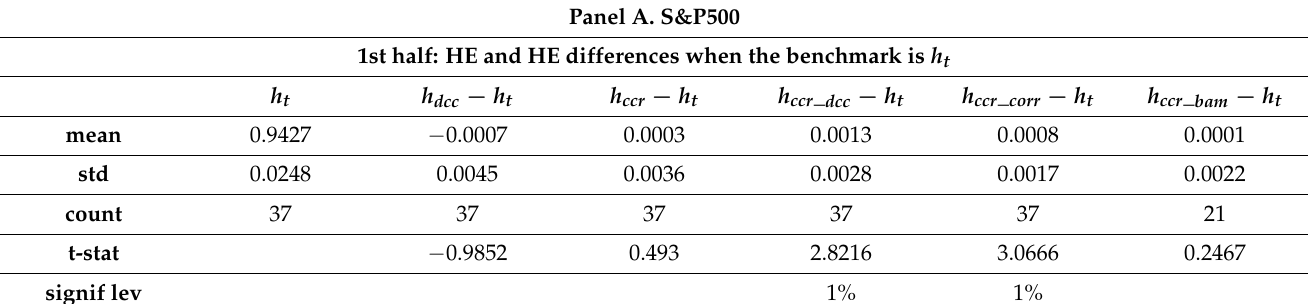
Table 3. Stability of the Benchmark HRs’ HEs and Differences from them. Panel A.